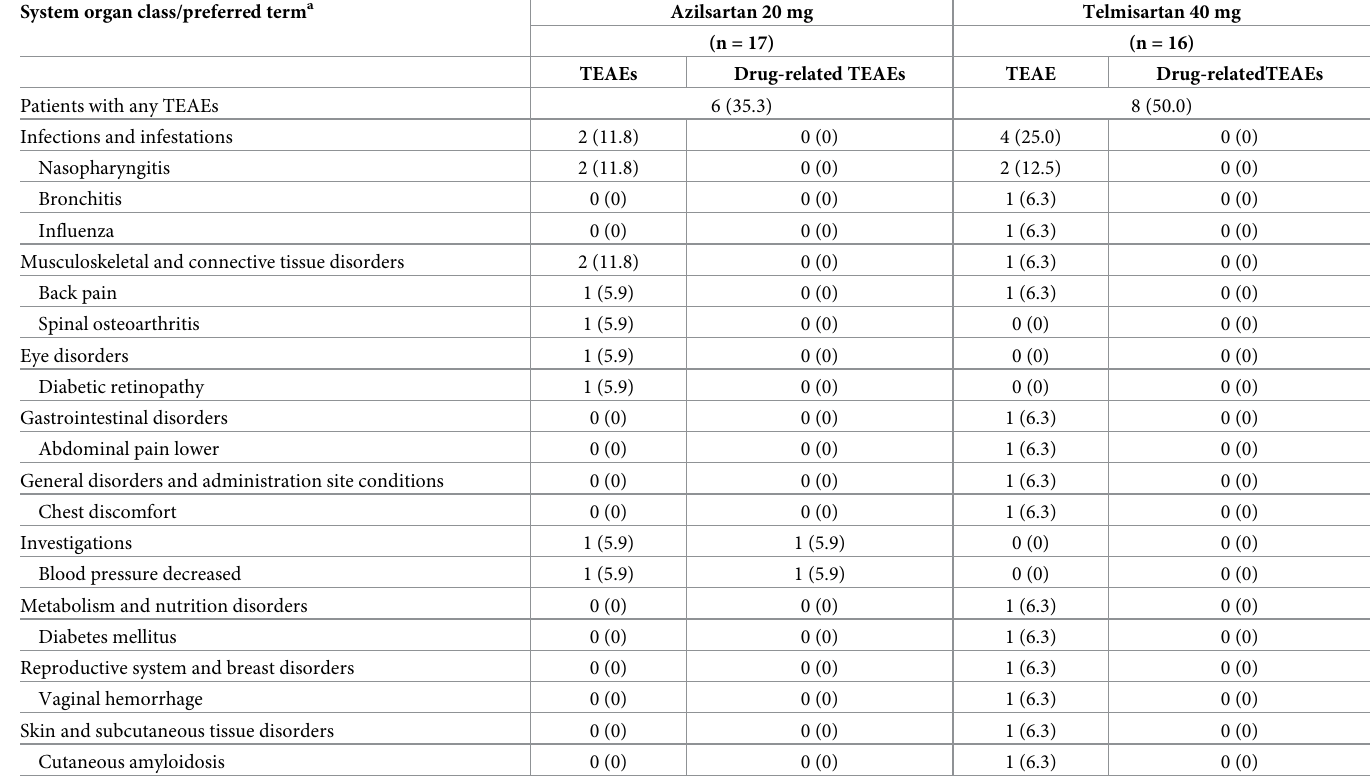
Table 6. Treatment-emergent adverse events during the treatment period